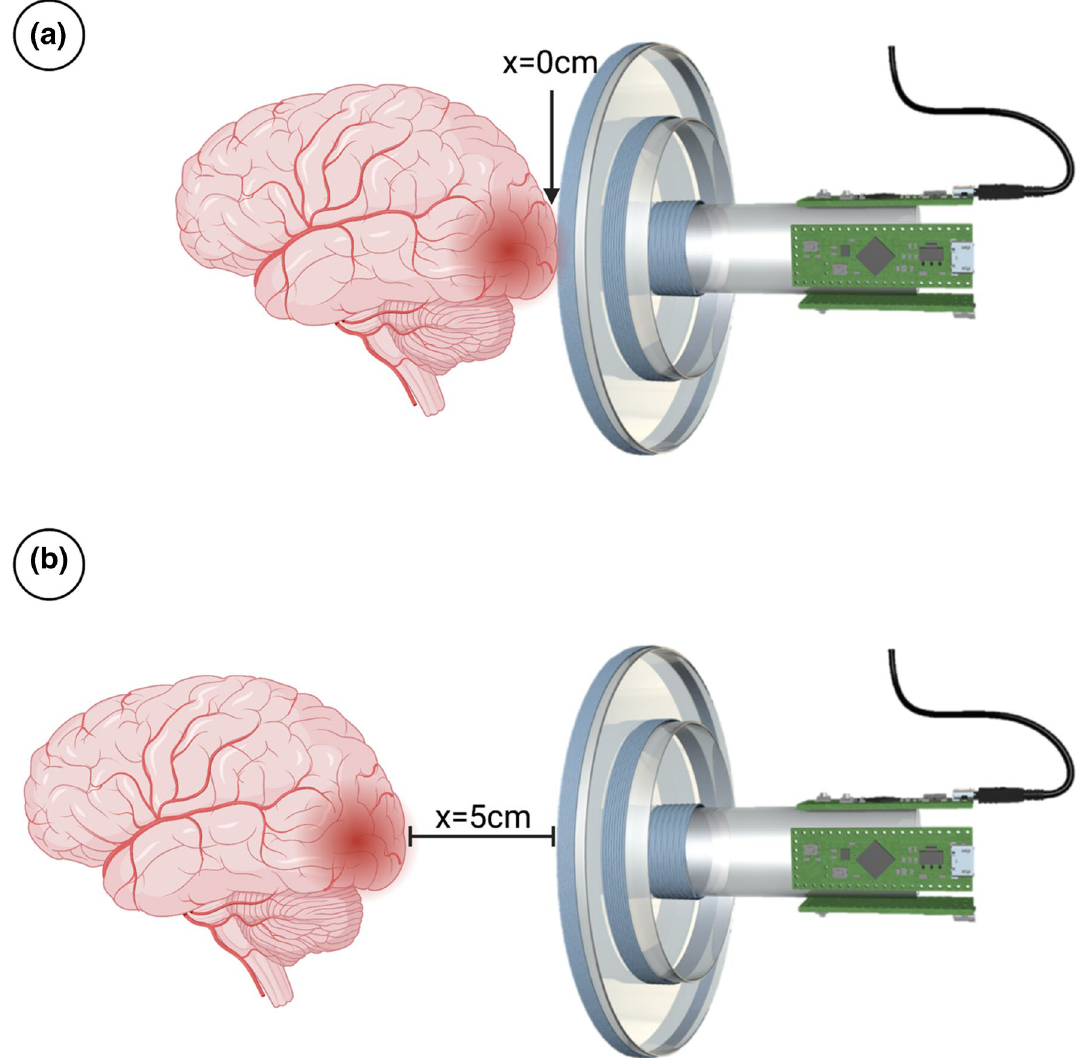
Figure 2. Schematic of the sensor and brain lesion at a distance of ( a ) x = 0 cm and ( b ) x = 5 cm. These distances from the center of the coil along the axis of symmetry are utilized to calculate the magnitude of the magnetic field using Biot-Savart’s Law. Image created using